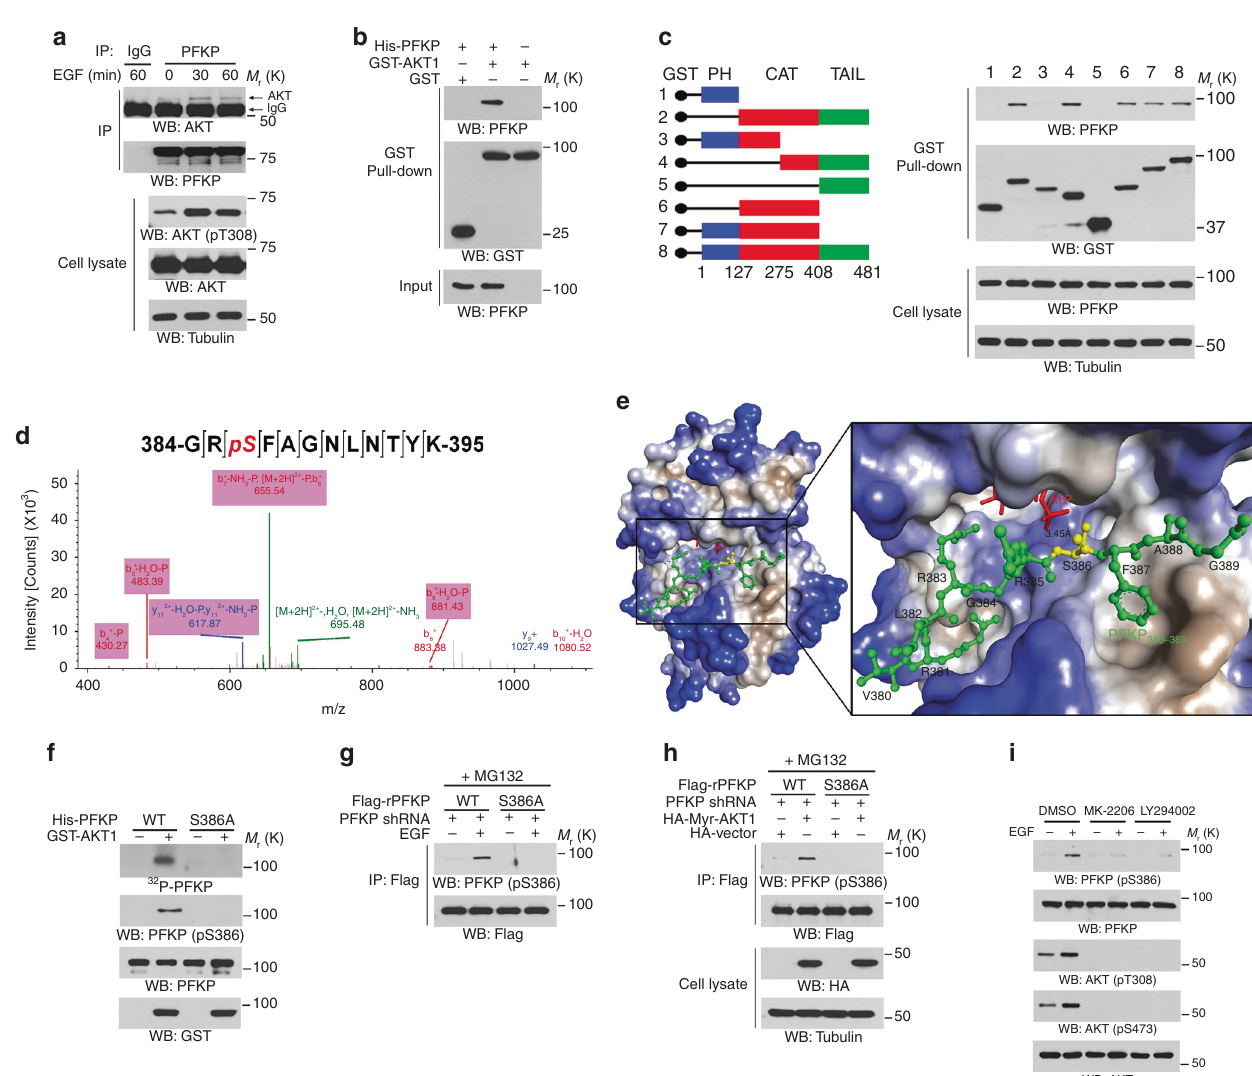
Fig. 3 AKT binds with and phosphorylates PFKP at Ser386. Immunoblotting analyses were performed with the indicated antibodies ( a – c , f – i ). MG132 (10 μ M) was added to the cells 6 h before harvesting to eliminate the potential effect of proteasomal degradation on PFKP proteins ( g , h ). a Serum-starved U251 cells were stimulated with or without EGF (100 ng ml − 1 ) for the indicated periods of time. Immunoprecipitation analyses were performed with an anti- PFKP antibody. b A GST pull-down assay was performed by mixing puri fi ed His-PFKP with puri fi ed GST or GST-AKT1. c A schematic representation of AKT1 full-length and deletion mutants is shown (left). 293 T cells were transfected with the indicated constructs. A GST pull-down assay was performed (right). d In vitro kinase assays were performed by mixing puri fi ed His-PFKP with or without puri fi ed GST-AKT1. A mass spectrometry analysis of a tryptic fragment of PFKP at a mass-to-charge ratio ( m/z ) of 704.32550 (mass error, 1.49 ppm) matched the 2 + charged peptide 384-GRSFAGNLNTYK-395, suggesting that S386 was phosphorylated. The Mascot score was 46, and the expectation value was 0.00058. e Electrostatic surface view of AKT1 in complex with unmodi fi ed PFKP (380 – VRLRGRSFAG-389 aa) peptide. Close-up view shows that PFKP (380 – 389) peptide fi ts into the AKT1 catalytic domain. PFKP S386 residue or γ -phosphate of ATP is highlighted in red or yellow, respectively. The structure was obtained from the PDB database: AKT (1O6L). f In vitro kinase assays were performed by mixing puri fi ed WT His-PFKP or His-PFKP S386A with or without puri fi ed GST-AKT1. g PFKP-depleted U251 cells were reconstituted with WT Flag-rPFKP or Flag-rPFKP S386A and then stimulated with or without EGF (100 ng ml − 1 ) for 60 min. An immunoprecipitation analysis was performed. h PFKP-depleted 293 T cells with reconstituted expression of WT Flag-rPFKP or Flag-rPFKP S386A were co-transfected with an HA vector or HA-Myr-AKT1. An immunoprecipitation analysis was performed. i Serum-starved U251 cells were pretreated with DMSO, MK-2206 (5 μ M), or LY294002 (20 μ M) for 2 h and then stimulated with or without EGF (100 ng ml − 1 ) for 60 AKT binds with and phosphorylates PFKP at Ser386 . To PTEN expression, with the highest level in NHA, were inversely correlated with the levels of AKT phosphorylation, PFKP determine the mechanism underlying AKT-regulated PFKP expression (Figs. 2g, h), and PFKP half-lives (Supplementary upregulation, we immunoprecipitated PFKP and performed Fig. 2g). Re-expression of WT PTEN in PTEN-de fi cient U251 liquid and U87 cells inhibited AKT phosphorylation and PFKP expression (Fig. 2i). These results indicate that AKT activation resulted from PTEN loss or EGFR-dependent PI3K activation tary Fig. 3a). Co-immunoprecipitation assays showed that Flag- induces PFKP upregulation. PFKP interacted with HA-AKT1/2 in 293T cells (Supplementary